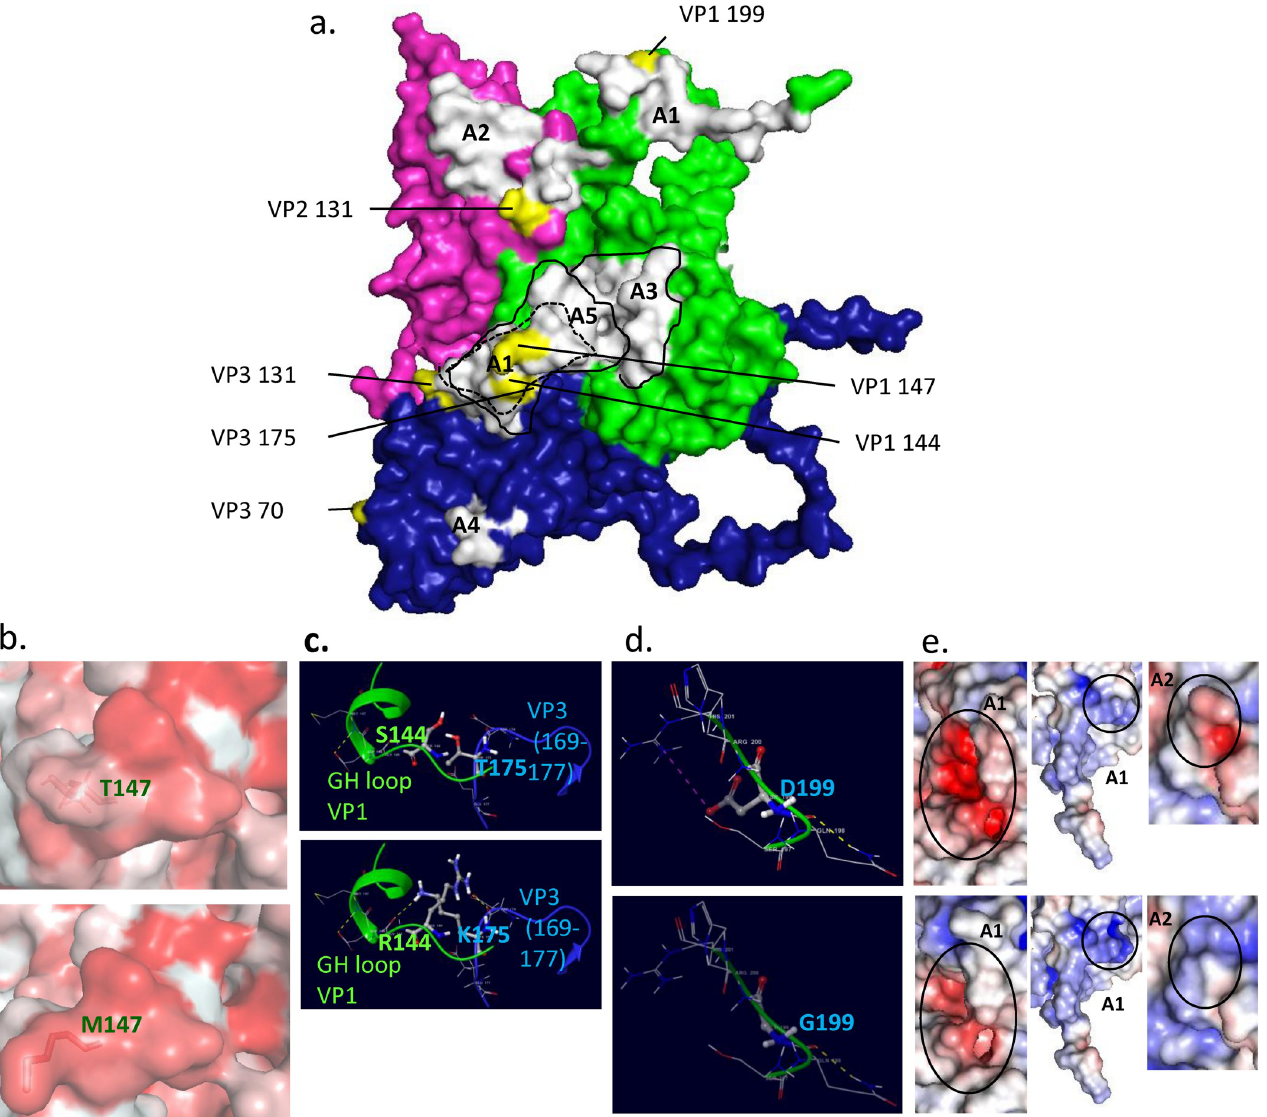
Fig 5. Consensus virus identity across infection. Boxes along each animal’s timeline indicates a virus sample. Colors and associated Roman numerals indicate clades based on inferred phylogenetic relationships (see Fig 4). Inoculum at left has been hypothesized as the source of the seven variant viruses detected. Abbreviations: DPI–days post-infection, Na–nasal secretion, Np–nasopharyngeal tissue (necropsy), OPF–oropharyngeal fluid (probang cup sample), Sa–saliva, Se–serum, Ves–epithelial vesicle. Three phases of FMDV infection were used to define progression of infection in individual animals: early, transitional, and persistent periods; temporal boundaries for the phases differ in vaccinated and non-vaccinated animals, as described in methods.